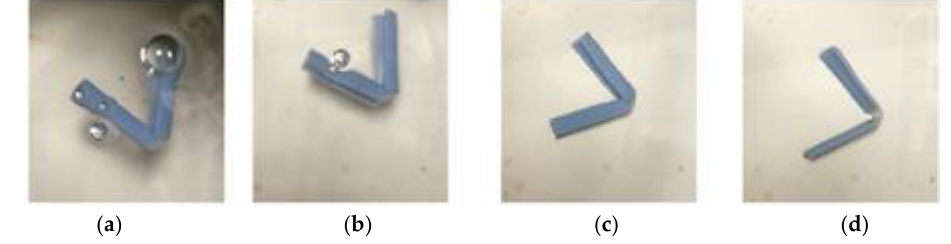
Figure 23. Method 2—the sequence of unfolding for the 0.1 mm sample. ( a – d ) Unfold along folding line 1.